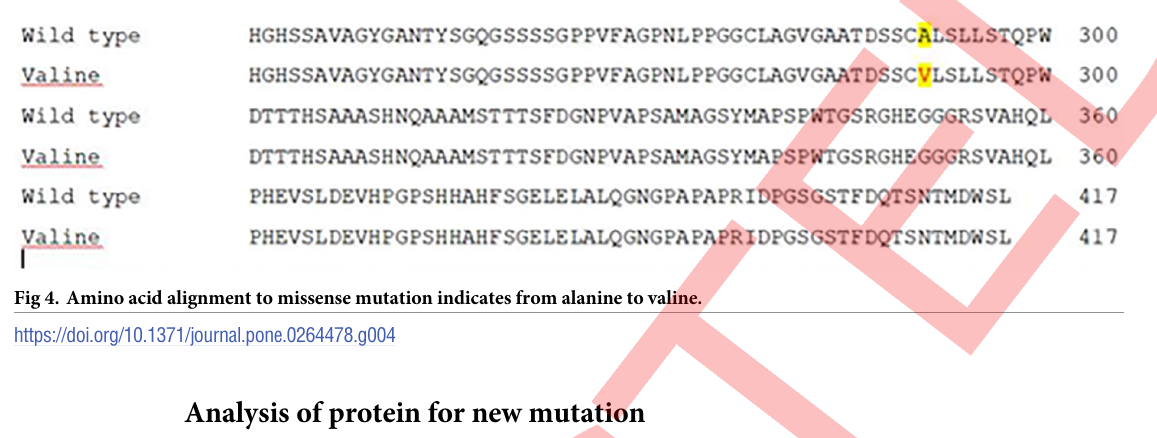
Fig 4. Amino acid alignment to missense mutation indicates from alanine to valine.